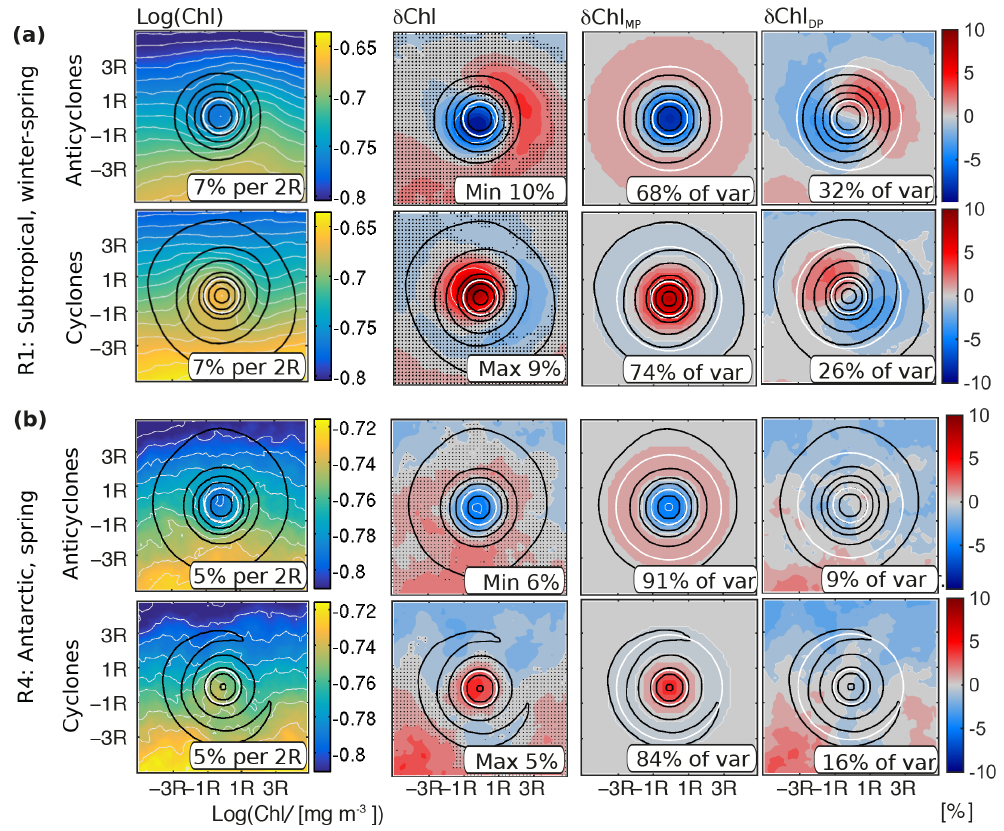
Figure 5. Attribution of stirring/trapping components of mesoscale eddy associated Chl; (a) average instantaneous Chl and δ Chl (see Method Sect. 2.4) in region R1 (SSH larger 10cm, June to November) and (b) in region R4 (SSH − 140 to − 100cm, October), indicated as white boxes in Figs. 4b, c and 7. Within each subpanel, the top rows show the results for the anticyclones, and the bottom rows for the cyclones. The left column shows the logarithm (base 10) of Chl, the middle left the δ Chl (stippling marks insignificant anomalies), the middle right one the monopole component, MP, and the right one the residual component (approximately a dipole component, DP; see text for details and cartoon in Fig. 1). The sea level anomaly contours are shown in black (normalized before averaging); the inner and outer white circles indicate the eddy core and area used for the computation of the contribution to the variance of δ Chl of the monopole and the dipole, respectively; text in panels denotes (left) the meridional Chl gradient at two eddy radii, (second left) the maximum or minimum of the anomaly, (second right and right) the contribution to the variance of the anomaly pattern of the monopole and dipole, respectively; before averaging, the individual eddy snapshots are rotated according to the ambient instantaneous Chl